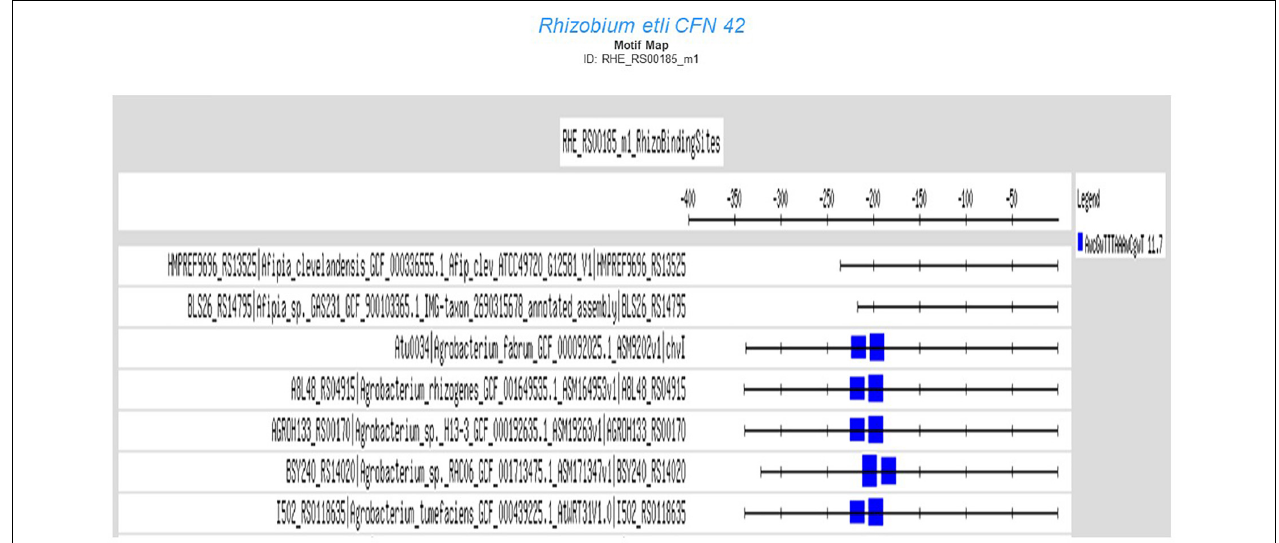
FIGURE 3 | Motif map of the RHE_RS00185_m1 matrix from R. etli CFN42 in orthologs from taxon